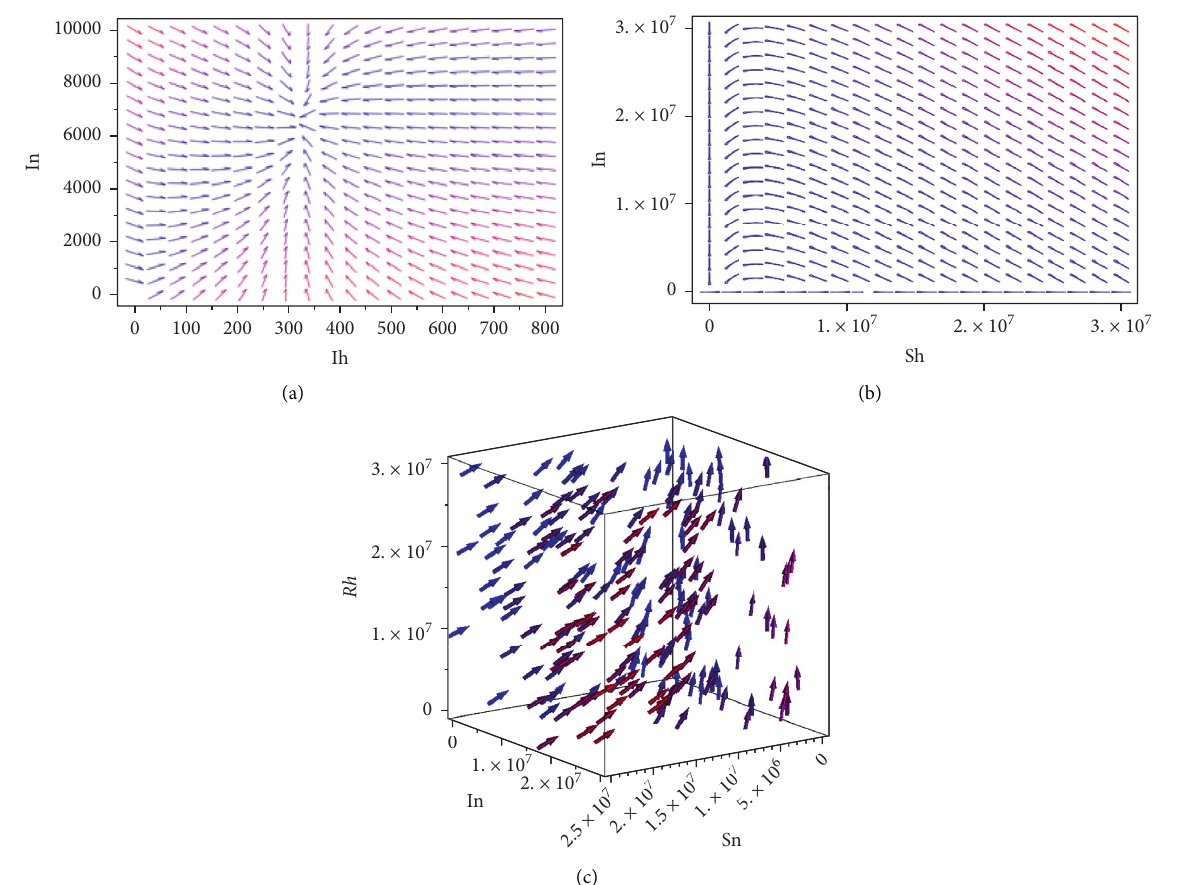
Figure 10: Phase portal for the SEIR model at the equilibrium points: (a) I